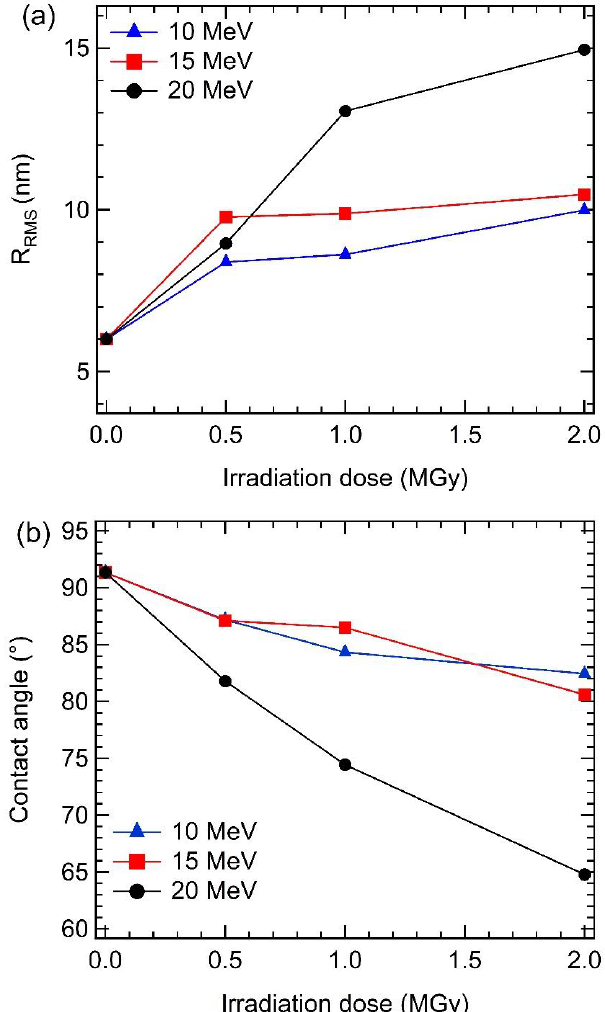
Figure 4. ( a ) R RMS values and ( b ) contact angle of the irradiated GaAs samples with electron